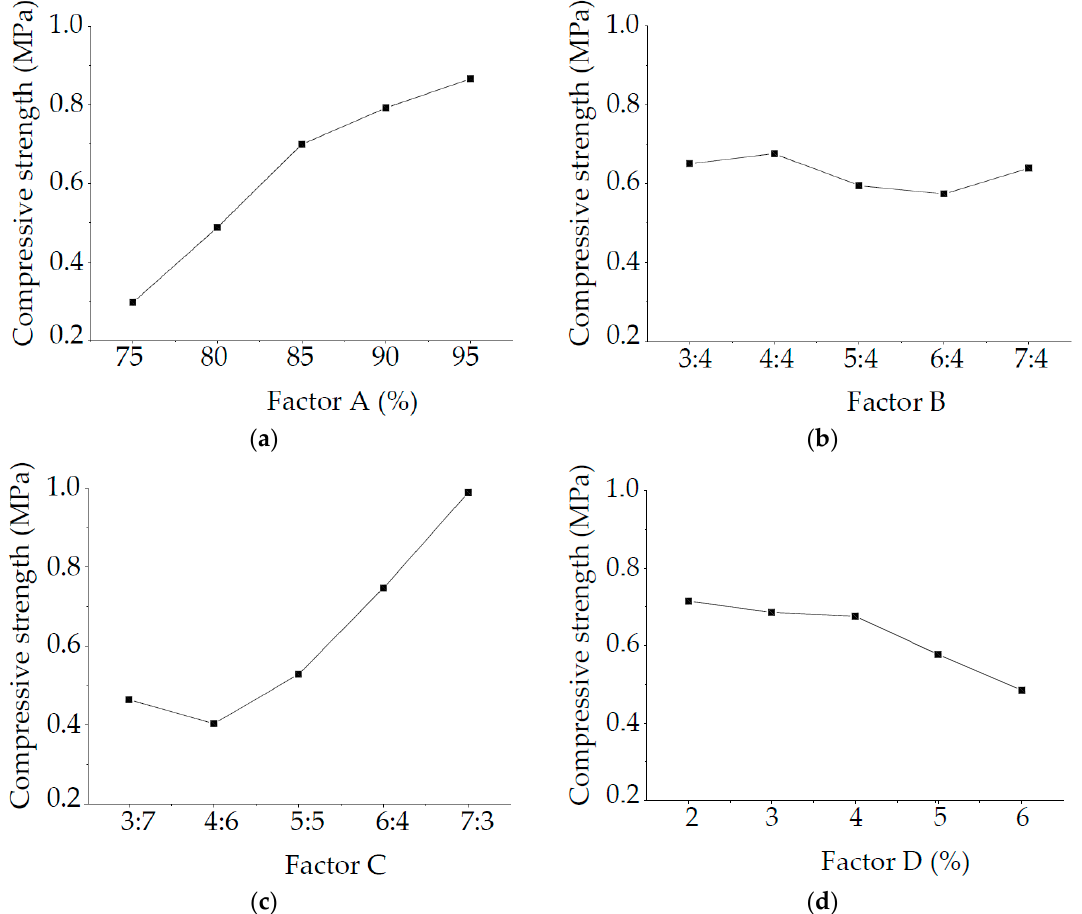
Figure 6. Intuitive analysis chart of compressive strength influencing factor: ( a ) Factor A; ( b ) Factor B; ( c ) Factor C; ( d ) Factor D.